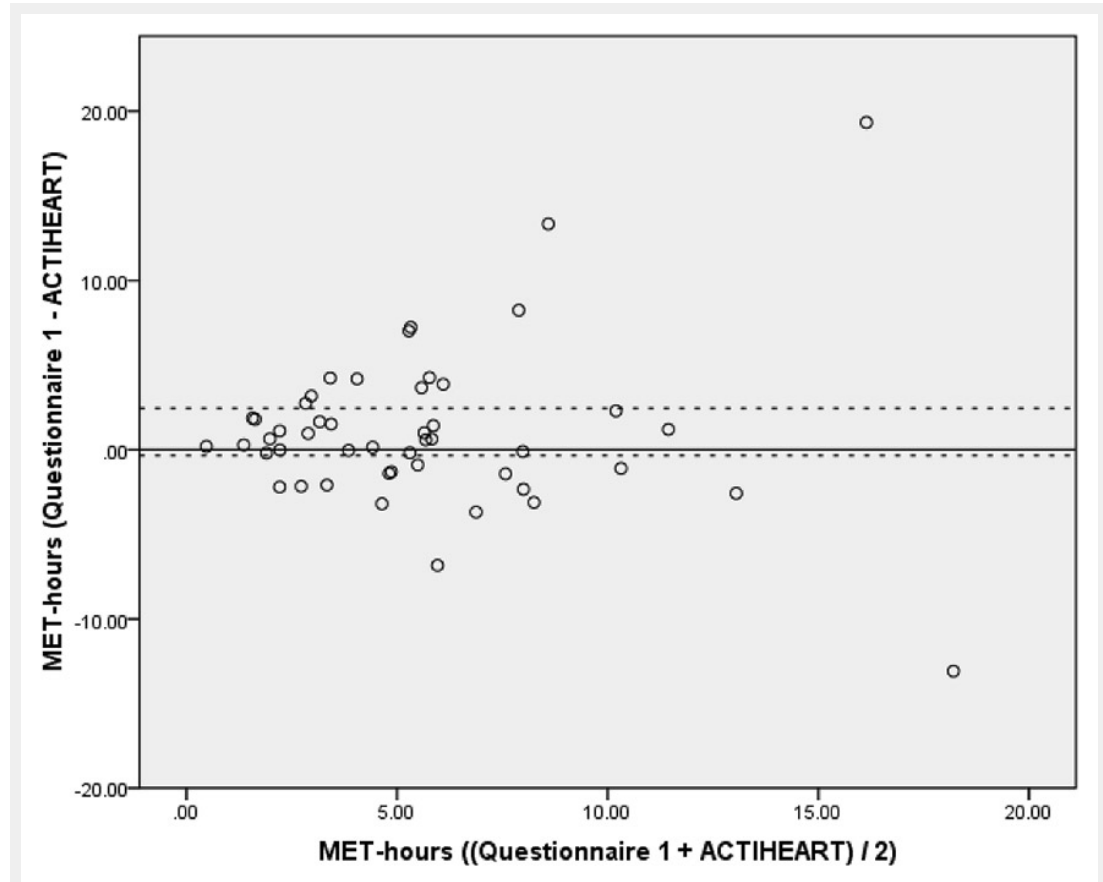
Figure 2 Bland-Altman plot of self-reported (questionnaire 1) minus measured (ACTIHEART) MET-hours (vertical axis) against mean of self-reported and measured MET-hours (horizontal axis). The solid horizontal line corresponds to the mean difference (1.05 MET-hours) while the dashed horizontal lines correspond to the 95% confidence interval (–0.34 to 2.44 MET-hours) (n =